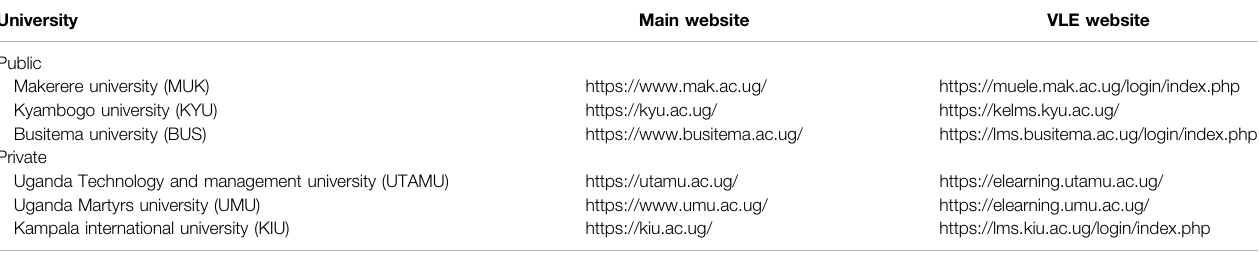
TABLE 1 | Universities whose VLEs were studied and courses evaluated.